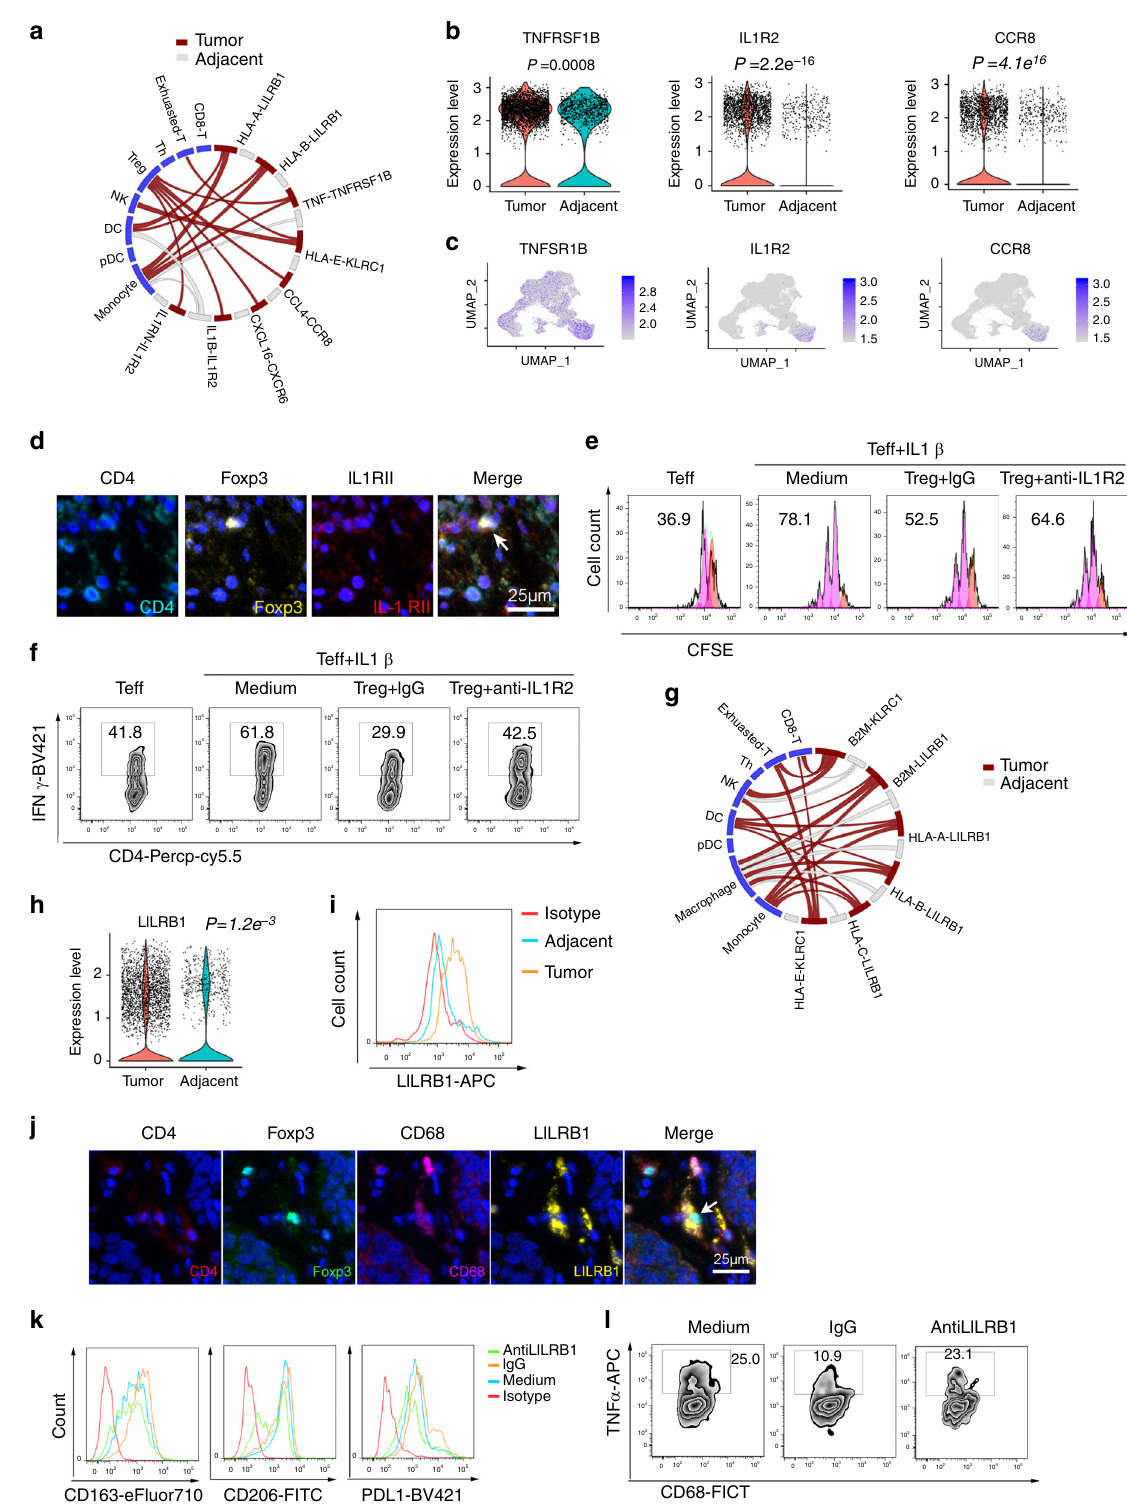
incubated with Opal Polymer HRP Ms + Rb (PerkinElmer) for 10 min at 37°C. The antigenic-binding sites were visualized using the Opal Seven-Color IHC Kit (PerkinElmer) according to the manufacturer ’ s protocol. Images were captured and analysis was performed with PerkinElmer Vectra 3.0.5 (PerkinElmer) and informs (PerkinElmer), respectively. The primary antibodies, IHC metrics and fl uorophores used in the validation of tolerogenic LAMP3 + DC, rabbit anti-human CD11C (Abcam, 1:200) (Oapl690), rabbit anti-human LAMP3 (Abcam, 1:100) (Opal620), rabbit anti-human IDO1 (Abcam, 1:100) (Opal520), and rabbit anti-human PDL1 (Abcam,